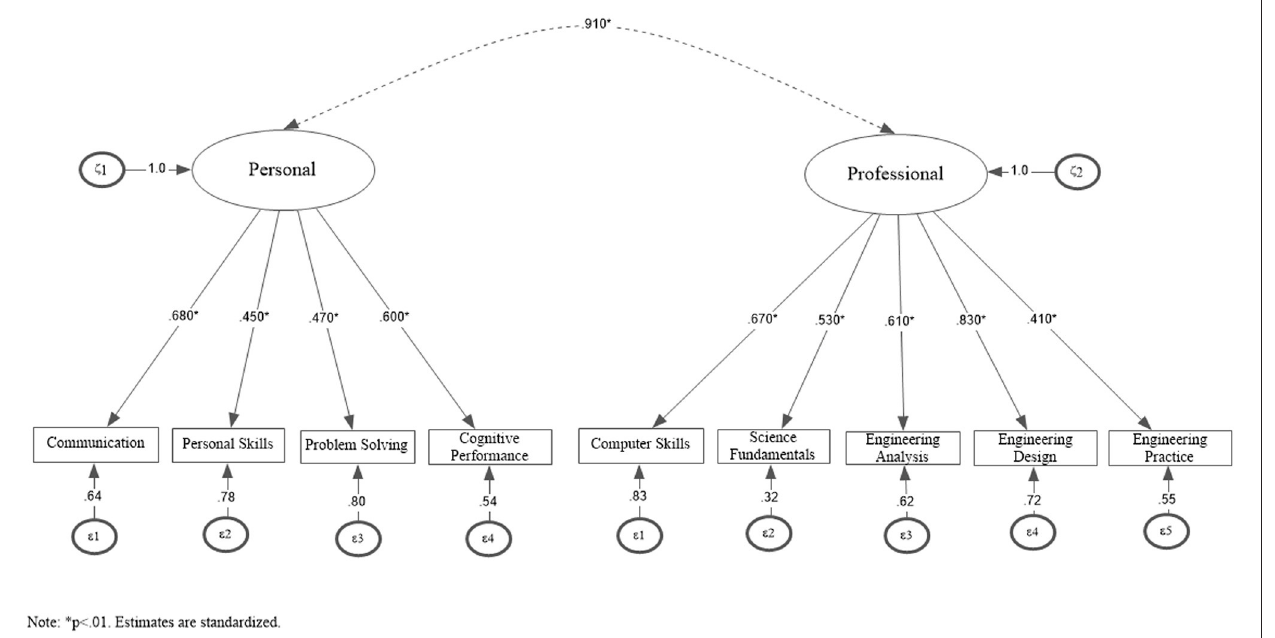
FIGURE 1 | Two-factor simple structure of the PrfEng test at the aggregate level, ignoring nesting ( N =